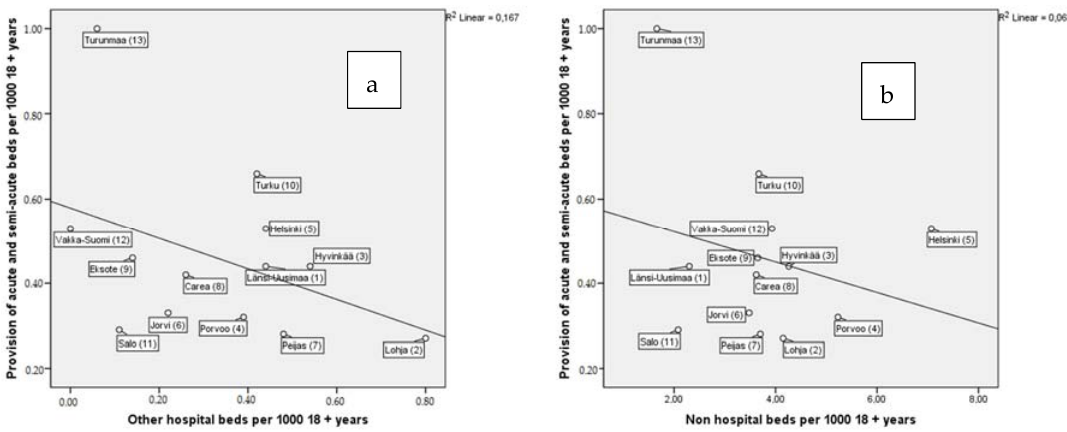
Figure 3. Associations between acute- and semi-acute (time-limited) inpatient treatment provision and; ( a ) other hospital bed- and ( b ) non-hospital bed- provision per 1000 adults (18+). The numbers in brackets after catchment areas indicate the data collection order and were used in a previous article [20].